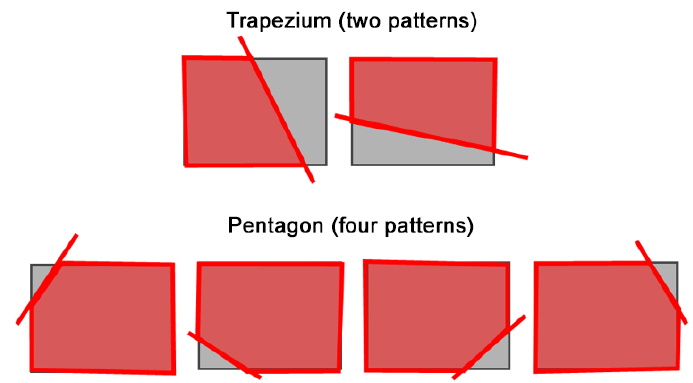
Figure 7. Different cases of camera frames after overlap area